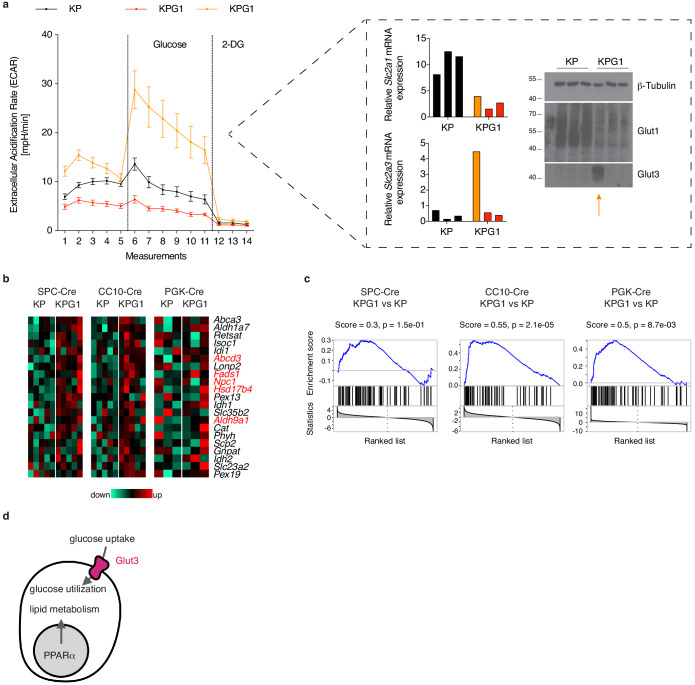
Glut1-deficient tumor analyses suggest Glut3- or PPARα-dependent compensatory mechanisms.(a) (left) Tumor-derived single cell preparations were placed in a Seahorse XF analyzer and subjected to longitudinal extracellular acidification rate (ECAR) measurements. Glucose or 2-deoxyglucose (2-DG) were added where indicated. Data are means ± s.e.m. of 3 KP and 3 KPG1 tumor-derived single cells each analyzed in ten or five technical replicates. The data from the outlier KPG1 are shown separately (orange) from the 2 other KPG1 tumors (red). (right) Real-time PCR and western blot analyses of Glut1 and Glut3 from the samples analyzed by Seahorse. (b) Bile acid metabolism genes from Hallmark collection (mSigDB) induced in KPG1 compared to KP from SPC-Cre, CC10-Cre and PGK-Cre tumors. Expression above the median is shown in red, below in green. Genes in red are PPARα targets (Rakhshandehroo et al., 2010). (c) Gene Set Enrichment Analysis (GSEA) of PPARα targets on genes ranked based on t-statistics when comparing KPG1 and KP tumors in SPC-Cre, CC10-Cre and PGK-Cre. p-values were obtained by normalized enrichment score (NES) of 105 random permutations. (d) Model illustrating two possible alternatives to Glut1 deficiency for tumor growth.Figure 3—source data 1.Source files for Seahorse analysis of KP and KPG1 tumors.